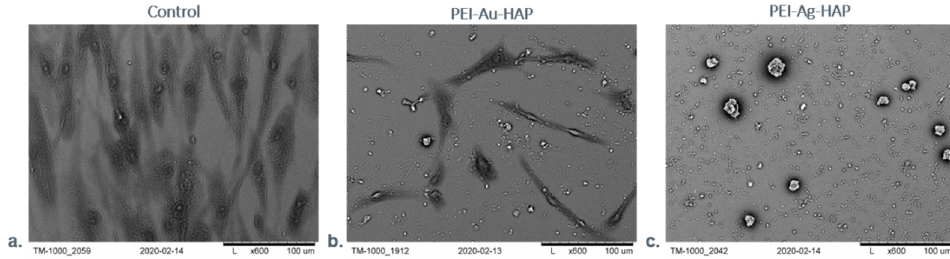
Figure 12. SEM visualization of HDF cells maintained in the absence (control)/presence of the selected, designed membranes after 7-days of the culture. Key to symbols: ( a ) Control ( b ) the membrane build of the hydroxyapatite mixed with polyethyleneimine with AuNPs incorporating (PEI-Au-HAP); ( c ) the membrane build of the hydroxyapatite mixed with polyethyleneimine with AgNPs incorporating (PEI-Ag-HAP). Magnitudes: ×1.0k.